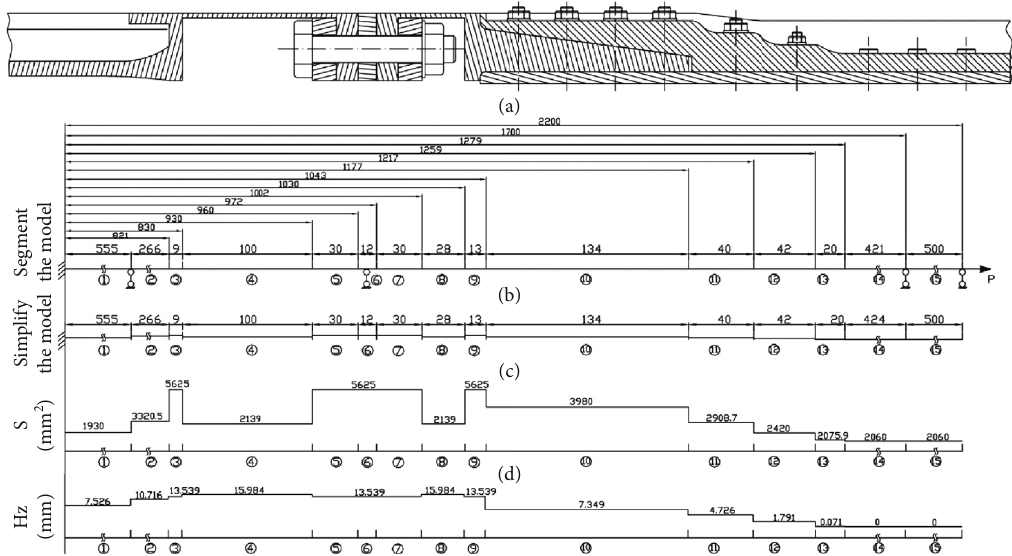
Figure 4: The segmentation and simpli fi cation of the model of the fi tting joint. (a) The longitudinal section of the fi tting joint; (b) the position of di ff erent cross-sections; (c) the segmented models of the fi tting joint; (d) The area of di ff erent cross-sections; (e) the height of the center of gravity of di ff erent